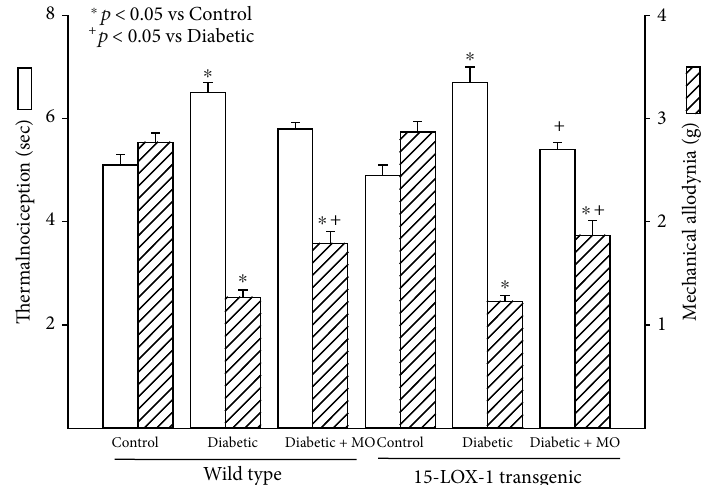
Figure 5: Treatment with menhaden oil of type 2 diabetic wild-type and 15-LOX-1 transgenic mice: e ff ect on thermal nociception and mechanical allodynia. Thermal nociception and mechanical allodynia were examined as described in Section 2. The number of mice in each group was the same as described in Table 1. Data are presented as the mean ± SEM in sec and g for thermal nociception and mechanical allodynia, respectively. ∗ p < 0 : 05 compared to their respective control mice; + p < 0 : 05 compared to their respective untreated diabetic mice.